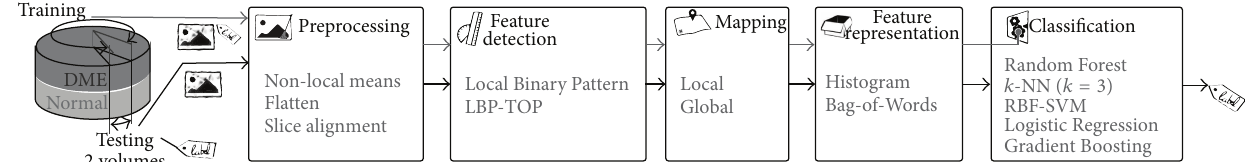
Figure 2: Our proposed classification pipeline.